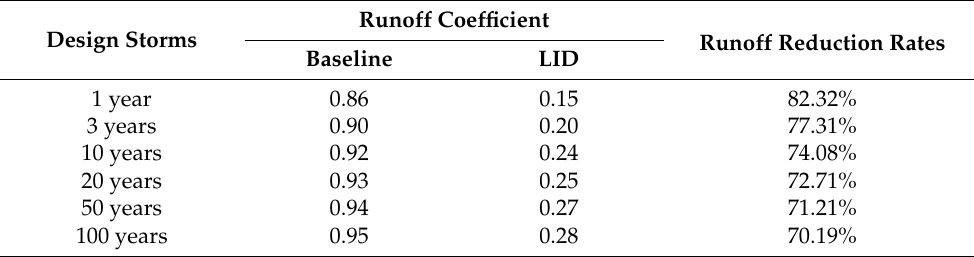
Table 6. Runoff reduction rates for various design storms.